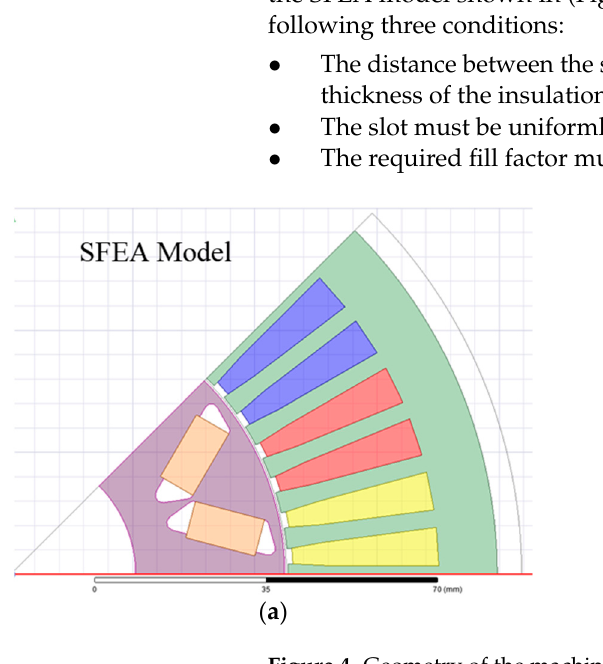
also evaluated based on the strand’s diameter and frequency using Formula (12).